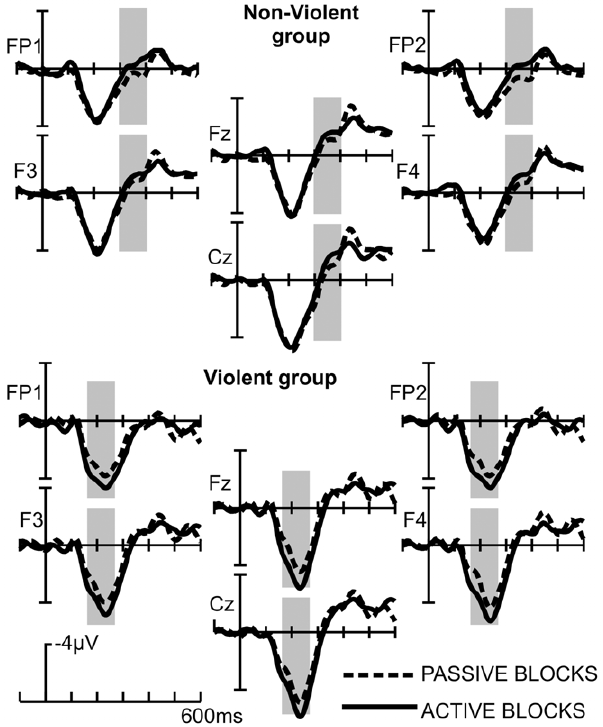
Figure 3. ERPs in the decision phase. Depicted are frontocentral electrodes locked to the onset of a question mark. Participants had the task to decide for a punishment. Grey-shaded areas indicate time windows for statistical analysis.